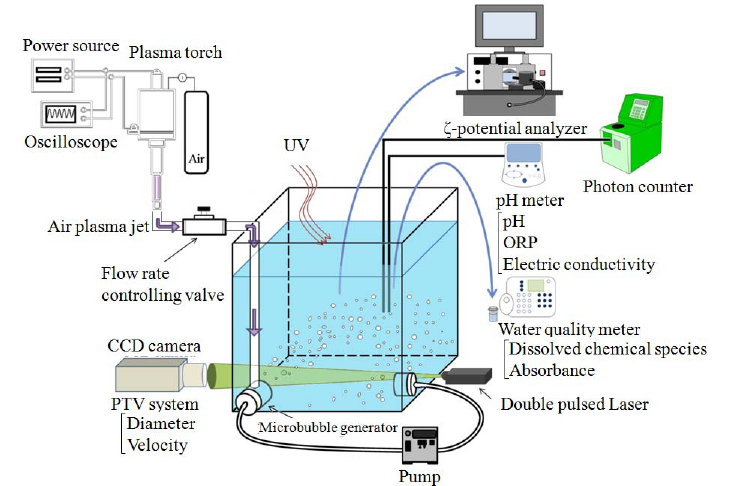
Fig. 1 Schematic illustration of experimental setup.